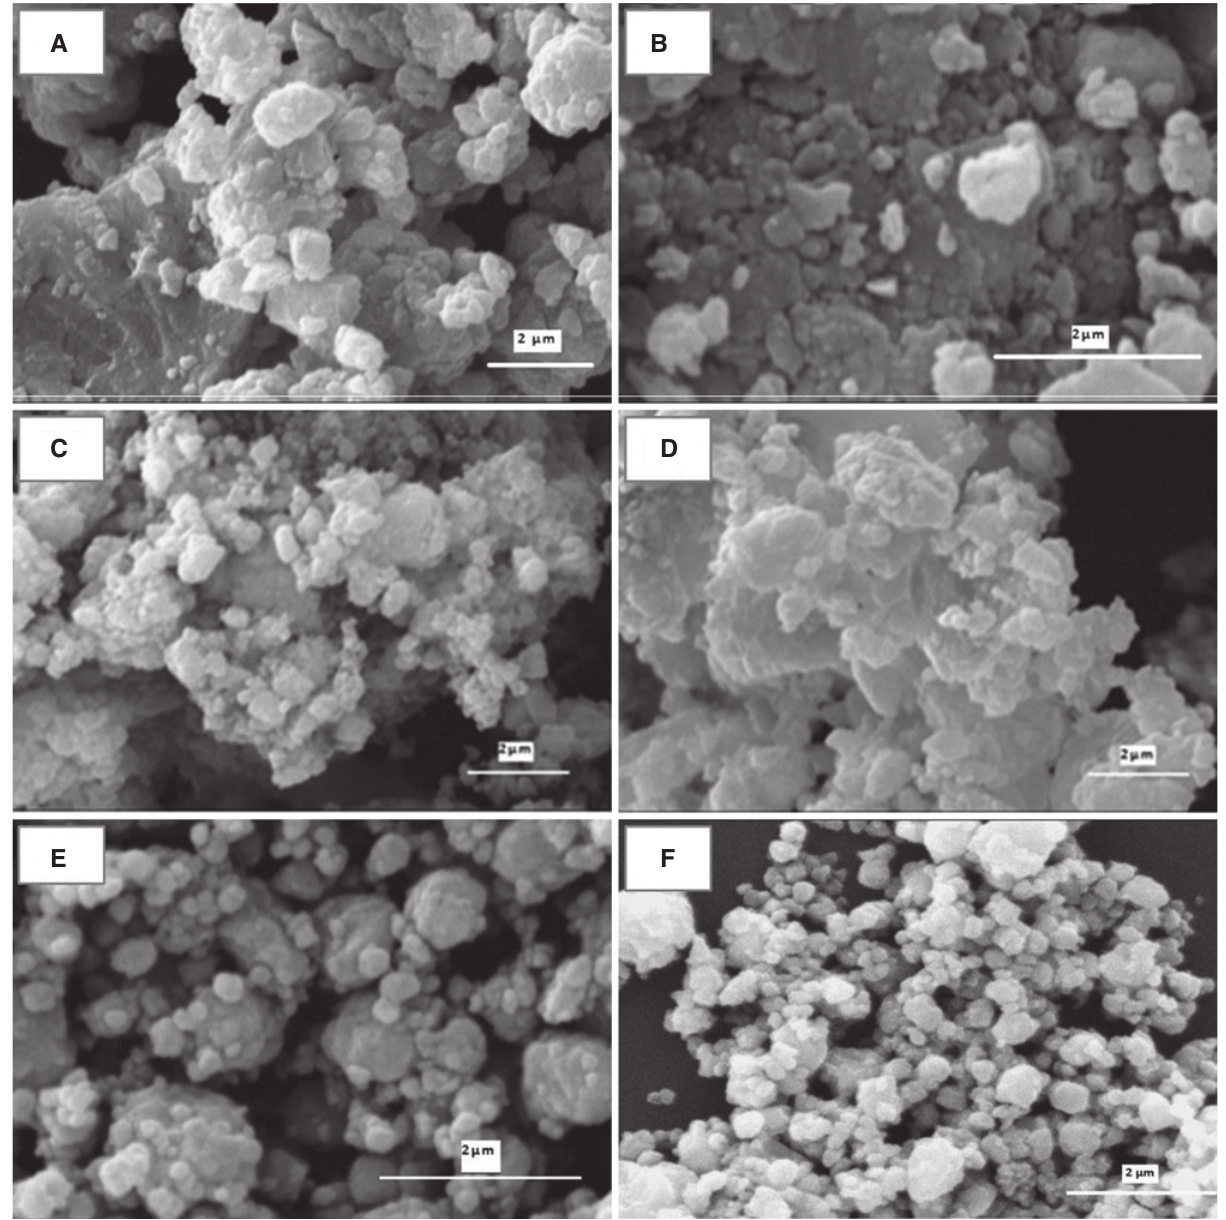
Figure 7: SEM images of (A) no milling and (B) 1.30 h, (C) 3 h, (D) 5 h, (E) 10 h, and (F) 20 h of